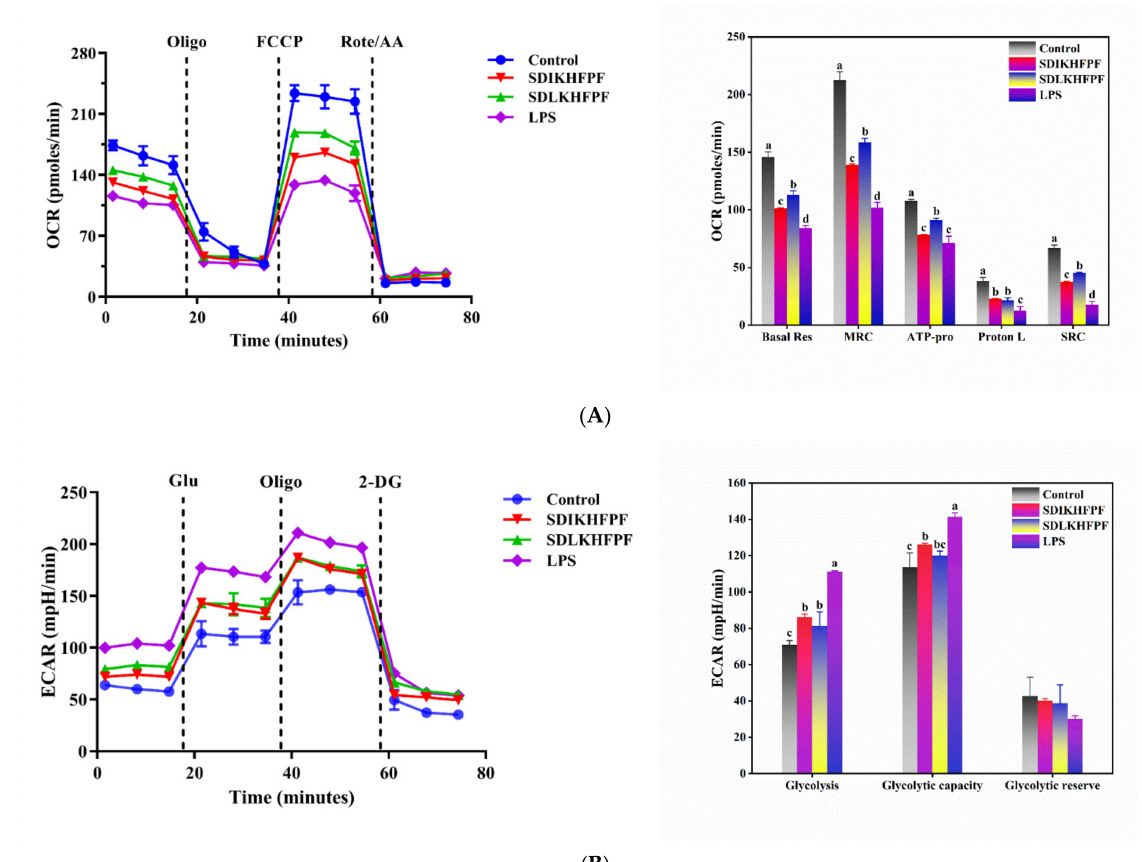
Figure 5. ( A ) Regulation of mitochondrial respiration by T. matsutake-derived peptides in LPS-induced RAW264.7 macrophages. The basal respiration (Basal Res), ATP production (ATP-pro), proton leak (Proton L), maximal respiration capacity (MRC), and spare respiration capacity (SRC) were calculated from the XF cell Mito stress test profile. ( B ) Regulation of glycolysis by T. matsutake-derived peptides in LPS-induced RAW264.7 macrophages. The glycolysis, glycolytic capacity, and glycolytic reserves were calculated from the XF glycolysis stress test profile. All of the data are indicated as the mean ± SD ( n = 3). Different letters mean statistically significant differences at the level of p <